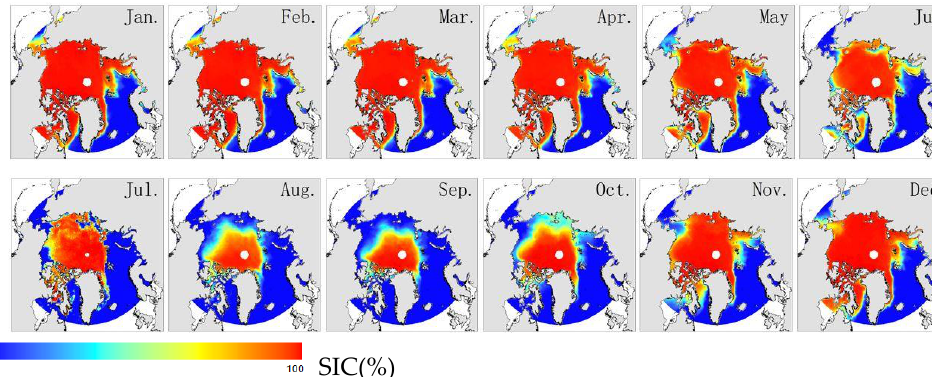
Figure 4. Monthly mean SIC in Arctic from 2002 to 2021.